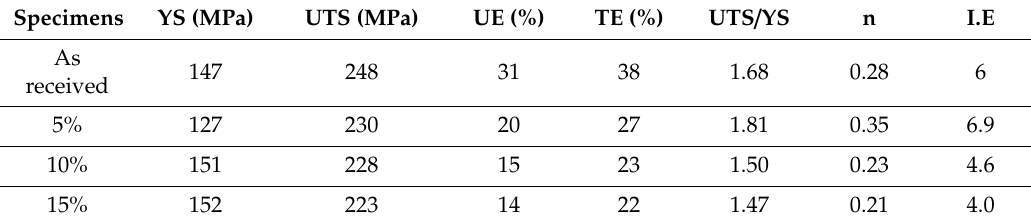
Table 2. Room-temperature tensile properties and Erichsen values of 5%-, 10%- and 15%-stretched samples. Erichsen tests were carried out at the punch speed of 0.1 mm /